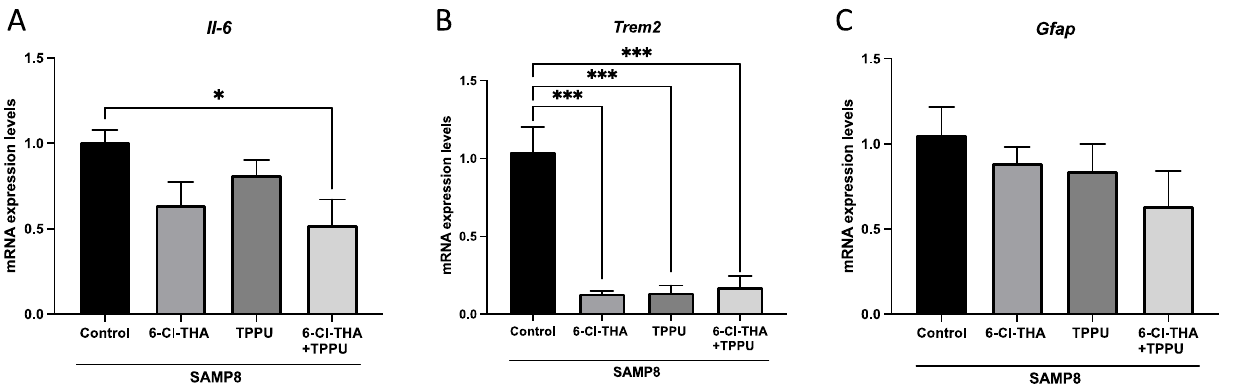
Figure 3. Gene expression of ( A ) Il-6 , ( B ) Trem2 and ( C ) Gfap . Results are expressed as a mean ± SEM. Groups were compared by the one-way ANOVA test and post-hoc Tukey’s test. SAMP8 control, n = 4; SAMP8 treated with the TPPU (1 mg/kg/day), n = 4; SAMP8 treated with 6-Cl-THA (1 mg/kg/day), n = 4; SAMP8 subjected to co-treatment with TPPU (1 mg/kg/day) plus 6-Cl-THA (1 mg/kg/day), n = 4. * p < 0.05; *** p < 0.001. Abbreviations: 6-Cl-THA = 6-chlorotacrine; Il-6 = interleukin-6; Trem2 = triggering receptor expressed on myeloid cell 2; Gfap = glial fibrillary acidic protein.